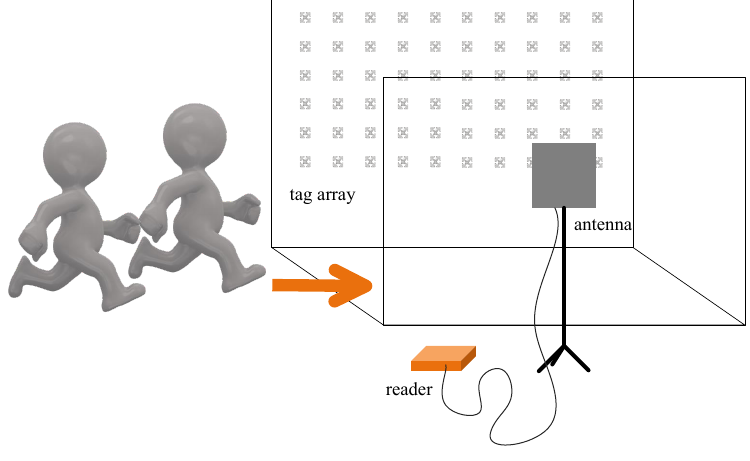
Figure 8. Tag-array-based intrusion